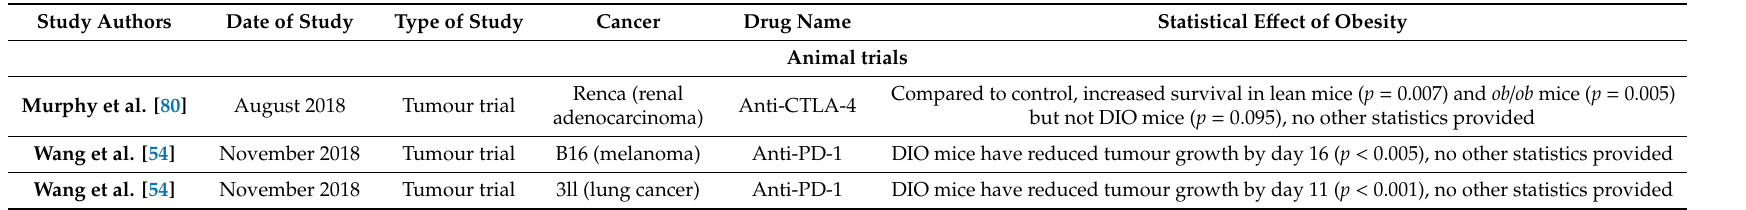
Table 2. The e ff ects of obesity on immune checkpoint blockade therapy for cancer trialled in animal